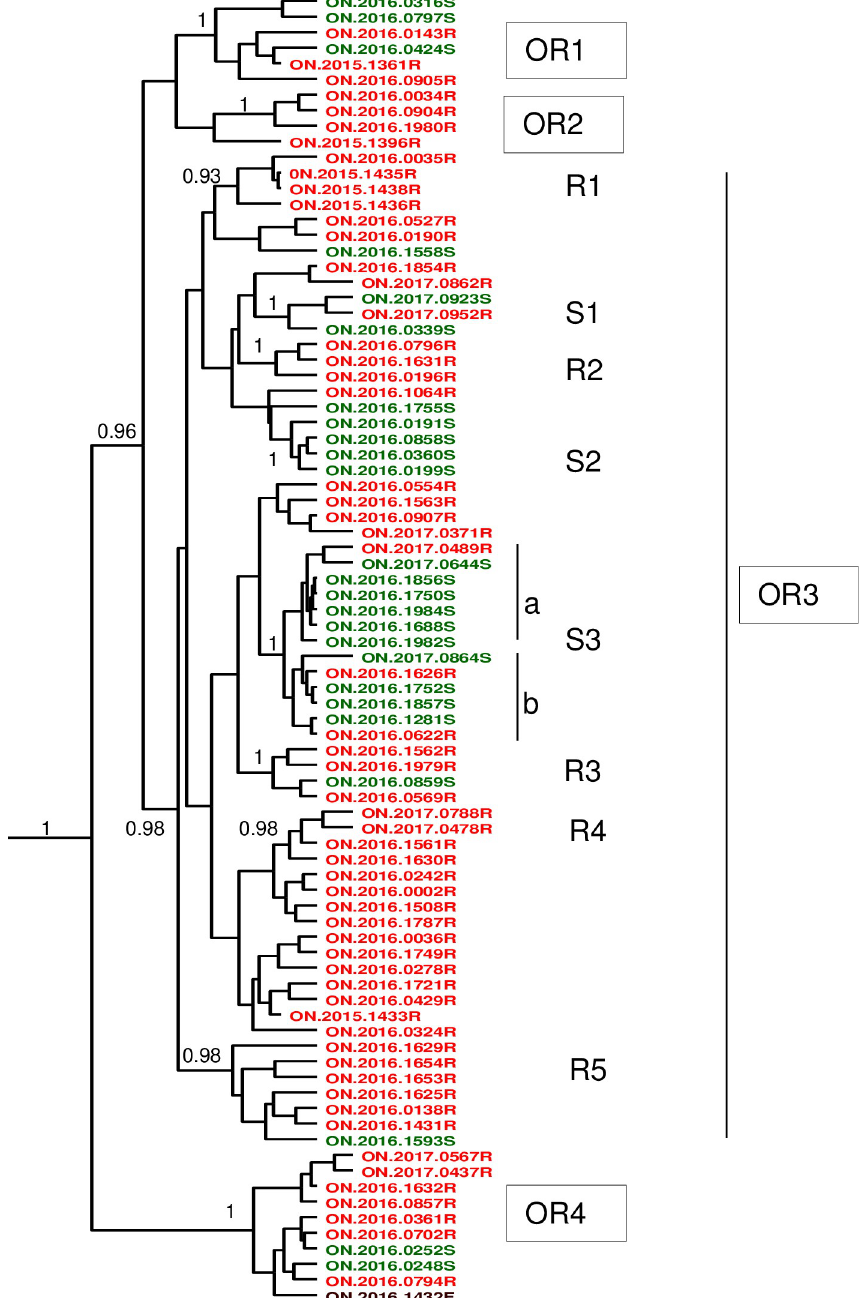
Fig 5. Phylogeny of the Hamilton RRV outbreak. An MCC tree of 84 samples was generated by coalescent analysis. The host species for each sample is indicated by the final letter in the sample name and by its color coding as follows: F, fox (brown); R, raccoon (red); S, skunk (green). Clades are identified to the right of the tree. Posterior values � 0.7 are shown to the left of the nodes. Sample NY.2003.7427R was used as